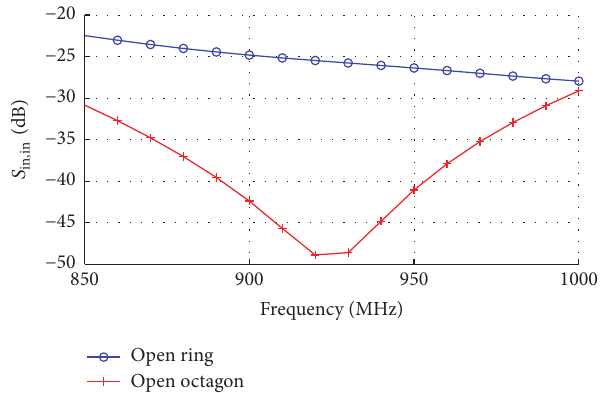
Table 2: Amplitude and phase feeding values for the antenna